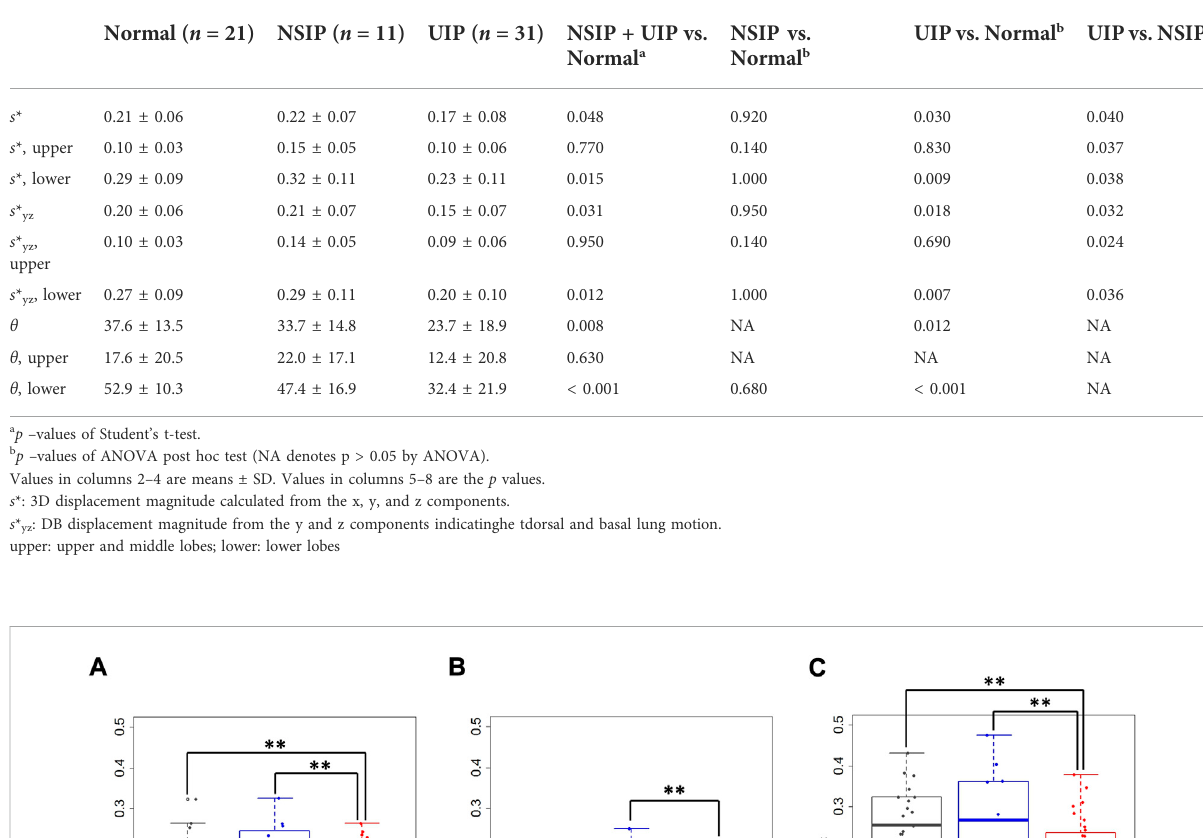
TABLE 2 Comparison of the motionographic variables between normal, NSIP, and UIP